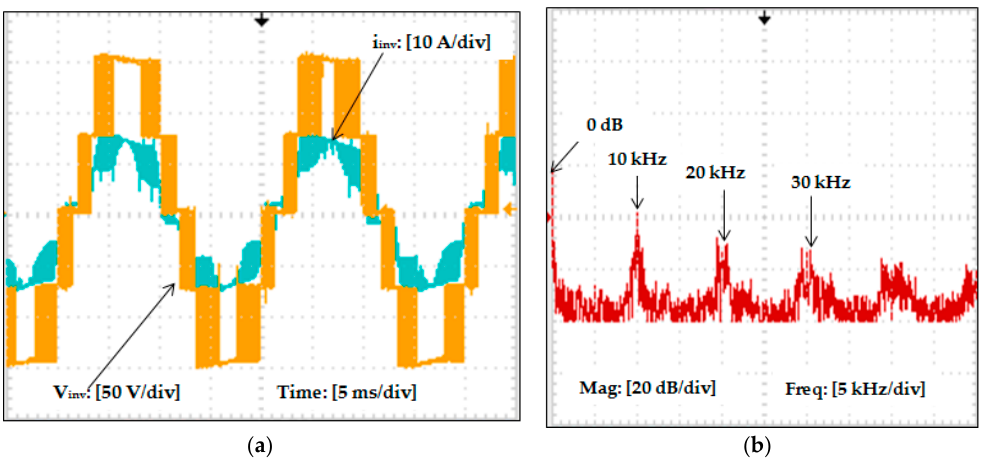
Figure 13. Experimental waveforms of the inverter output before connecting passive filter: ( a ) output voltage and current waveforms; and ( b ) output current harmonic spectrum.